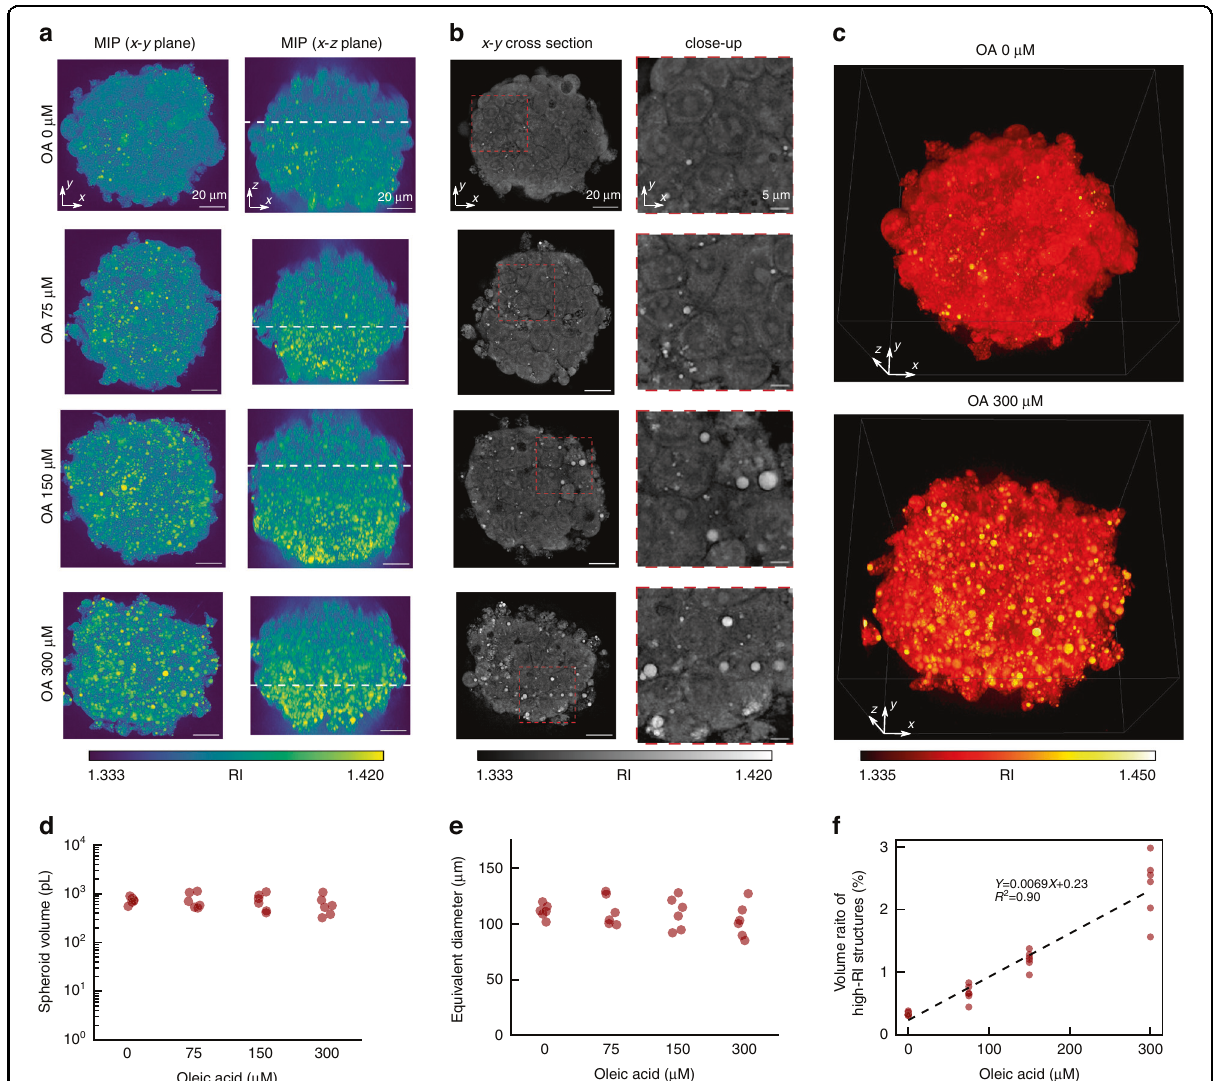
Fig. 5 Semi-quantitative assessment of high-RI structures using in-silico clearing RI tomography. a Maximum intensity projection (MIP) and b cross-sections of the RI maps of HepG2 spheroids at oleic acid (OA) concentrations of 0, 75, 150, and 300 µM. The depth of cross-sections is identi fi ed with white dashed lines in MIP images. c 3D rendering of RI distribution at OA concentrations of 0 µM and 300 µM, respectively. Plots of ( d ) spheroid volume, ( e ) equivalent diameter, and ( f ) volume ratio of high-RI structures as a function of OA concentration. Six spheroids are measured for each OA concentration (a total of 24 spheroids). The fi tted line in ( f ) has a slope of 0.0069%/µM and an intercept of 0.23% with a coef fi cient of determination R 2 =